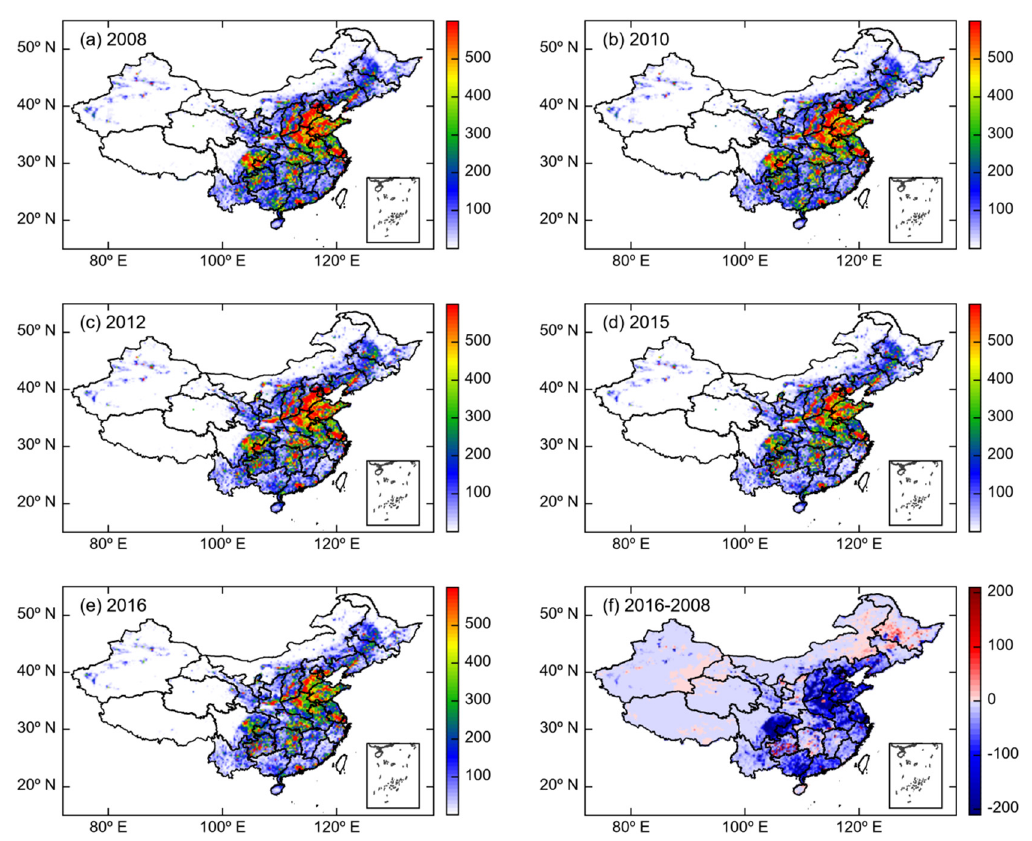
Figure 7. China BC emission inventory at 0.25 ° × 0.25 ° in ( a ) 2008, ( b ) 2010, ( c ) 2012, ( d ) 2015, ( e ) 2016, and ( f ) 2016 minus 2008, unit: ton grid − 1 .